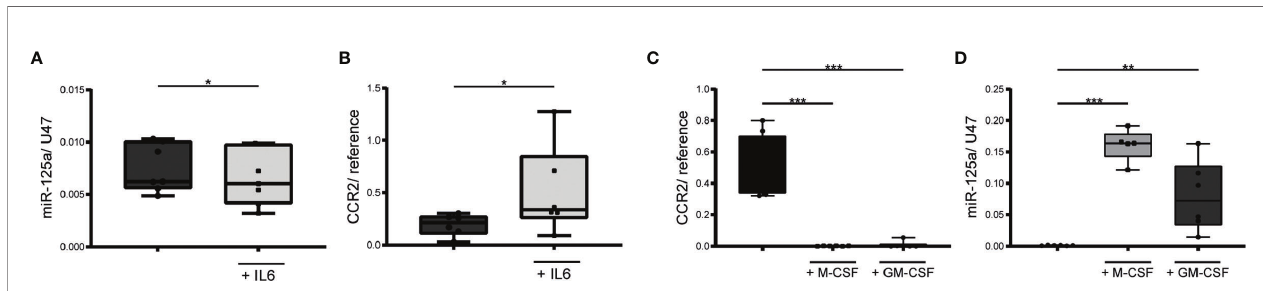
FIGURE 7 | MiR-125a and CCR2 expression in monocytes during in fl ammation and monocyte differentiation. Expression levels of miR-125a (A) and CCR2 (B) after incubation of primary human monocytes with IL6 for 3 hours (n=7, *p<0.05). Quanti fi cation of CCR2 (C) and miR-125a (D) expression in primary human monocytes immediately after differentiation with M-/GM-CSF for 6 days. (n=5-6,